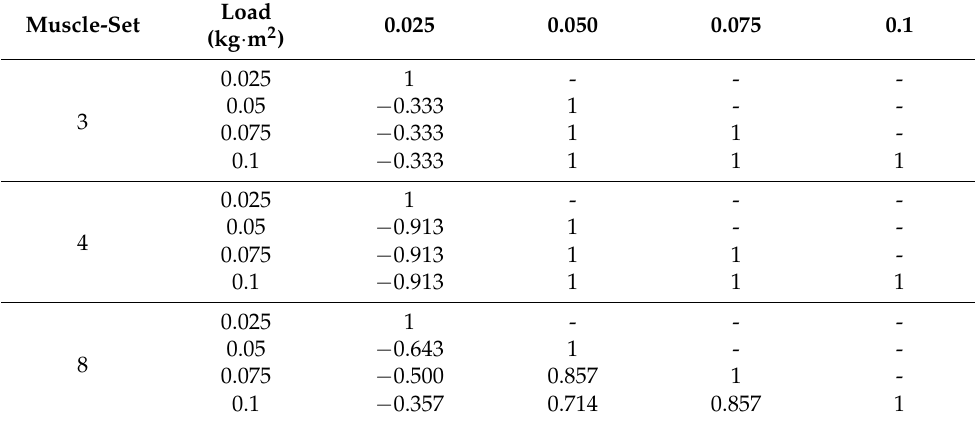
Eight muscle sequence set corresponds to: soleus (sol); lateral gastrocnemius, semimembranosus, biceps femoris (bf), vastus medialis, vastus lateralis (vl), rectus femoris and glutes maximus (glut) muscles; 4 muscles: sol, bf, vl and glut; 3 muscles: sol, vl,